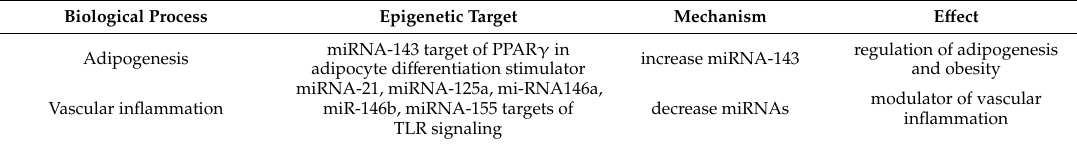
Table 3. LCPUFAs’ impact on miRNA-mediated epigenetic